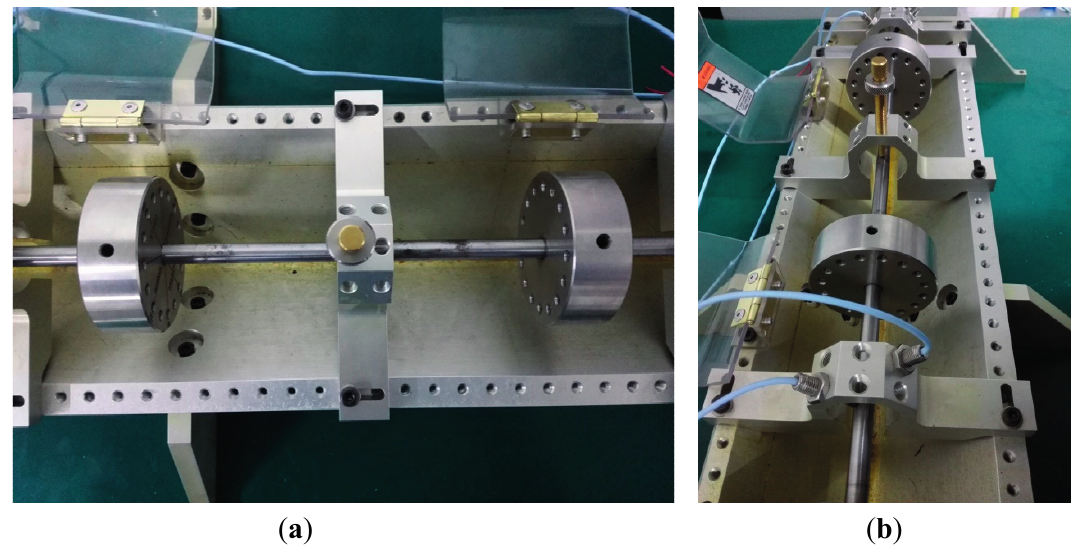
Figure 11. Installation effect of rubbing ( a ) vertical view; ( b ) side